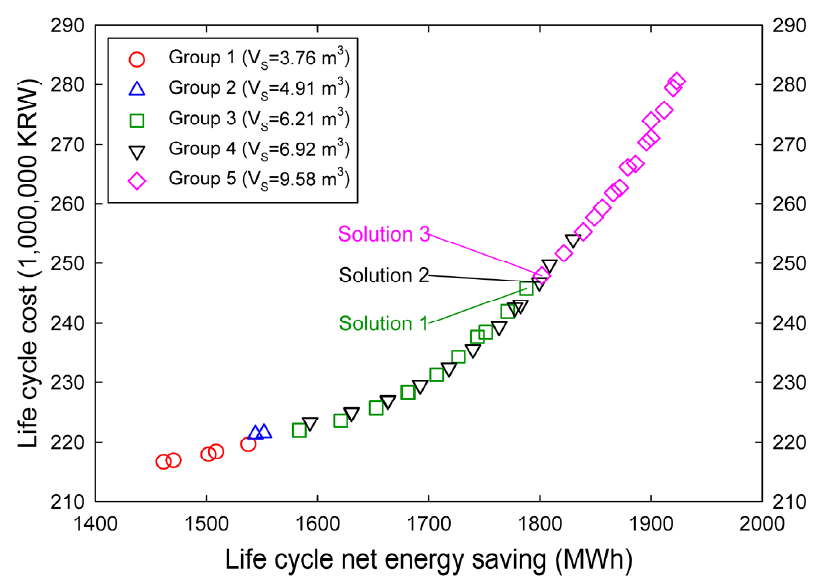
Figure 10. Pareto frontier for last generation divided by storage tank volume. Table 4. Characteristics of three non ‐ dominated solutions considered in Figure 10.